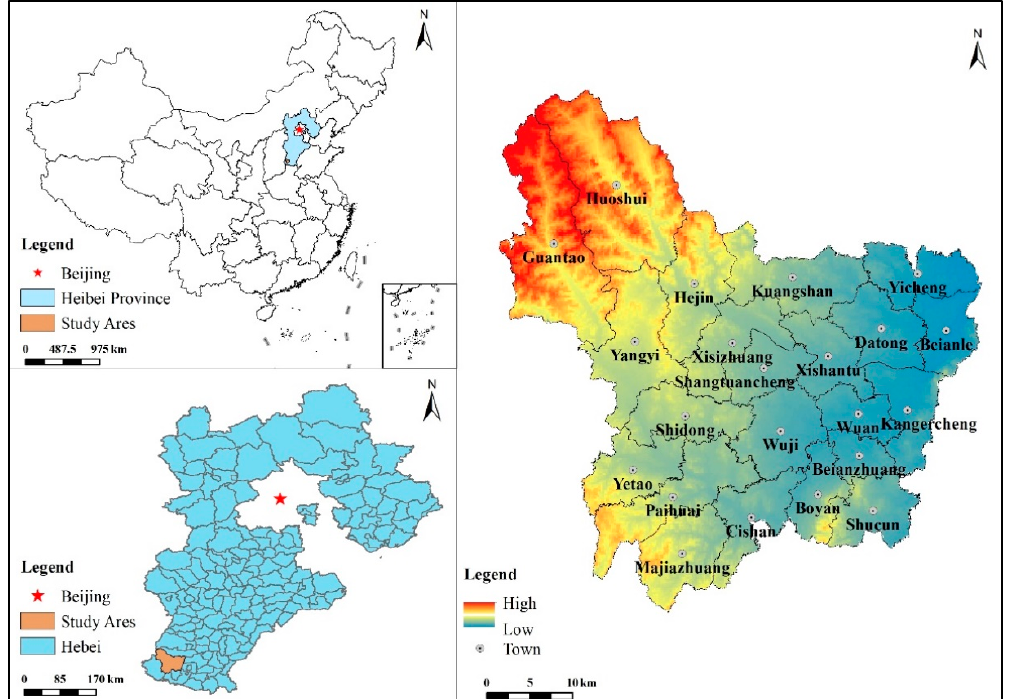
Figure 1. Location of the study area: Wu’an, China.